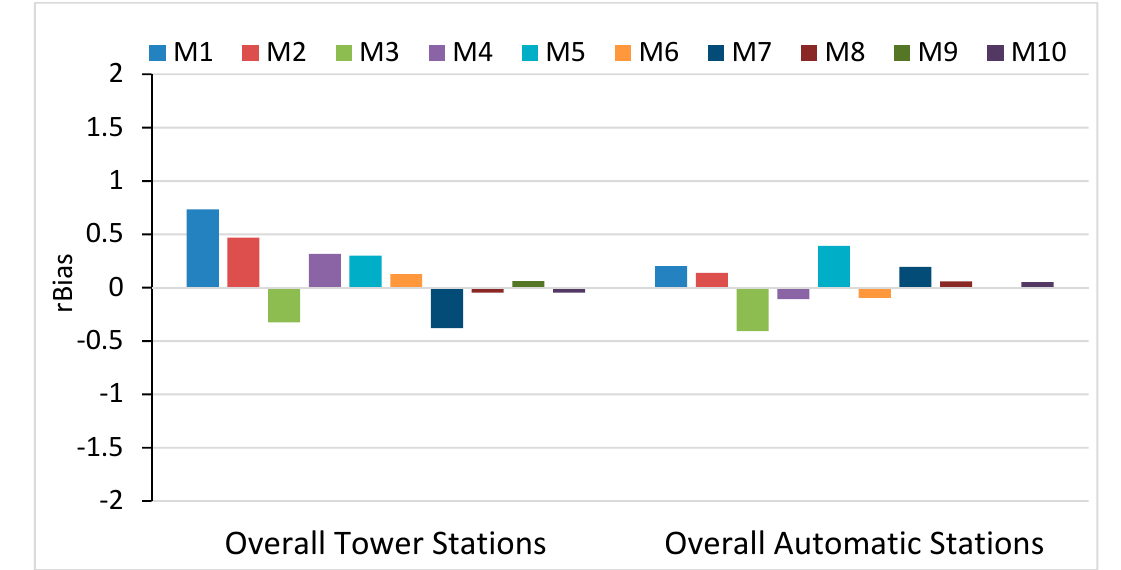
Figure 4. Comparison of rBias for the hourly GHI among models and for the overall results of station types.